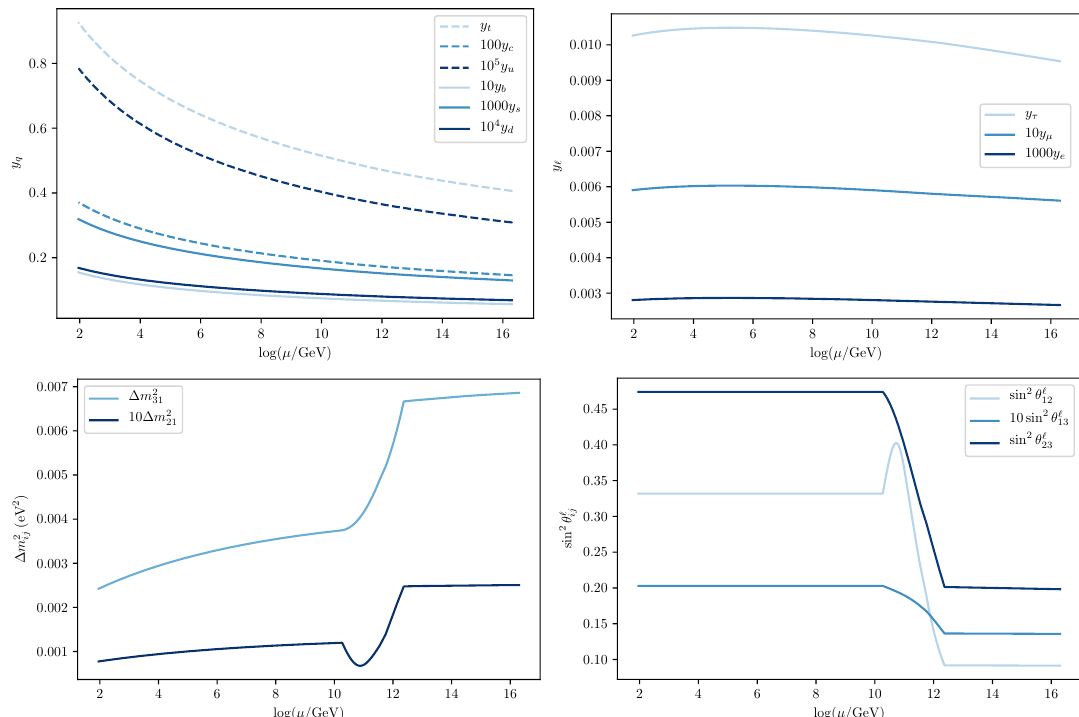
Figure 2 . Renormalization group evolution of some quantities for the (cid:12)t with type-I+II seesaw and normal neutrino mass ordering as functions of the energy scale (cid:22) between M Z and M GUT . Upper-left panel: quark Yukawa couplings (singular values of Y u and Y d ). Upper-right panel: charged-lepton Yukawa couplings (singular values of Y ‘ ). Lower-left panel: neutrino mass-squared di(cid:11)erences (Di(cid:11)erences of squared singular values of the neutrino mass matrix, multiplied by v 2 right panel: sine squareds of the leptonic mixing angles calculated from the mixing between the charged-lepton Yukawa matrix and the neutrino mass